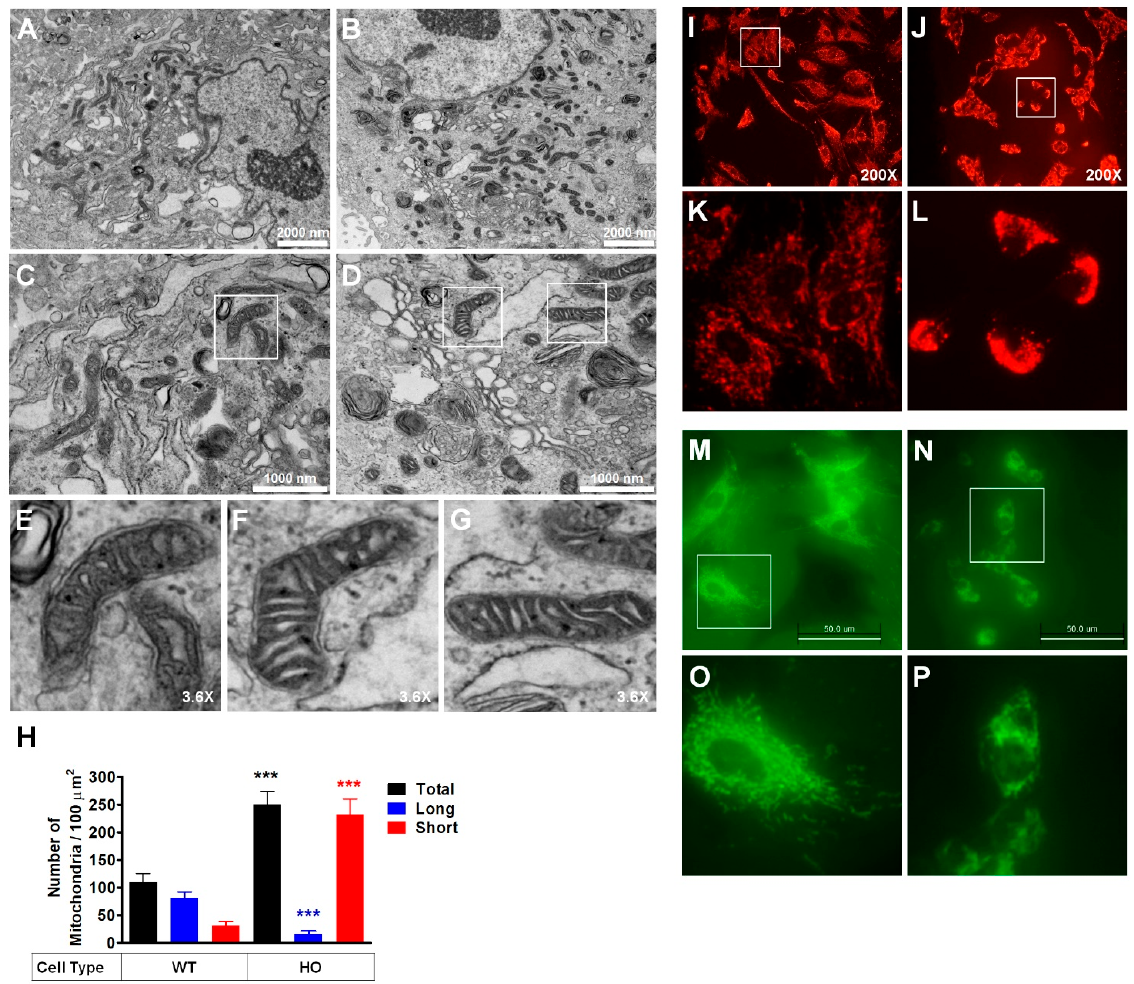
Figure 1. Altered mitochondrial morphology and network. ( A – G ) Representative images showing mitochondrial morphology in WT and GCD2 corneal fibroblasts. EM micrographs of a thin section of corneal fibroblasts show the structure of mitochondria in WT and GCD2 corneal fibroblasts. Many abnormal mitochondria (short or fragmented) were observed in GCD2 cells compared with WT cells. Scale bars are 2000 nm ( A , B ), and 1000 nm ( C , D ). ( H ) Graphs on the right show mitochondrial morphological features. Mitochondrial numbers were measured in 6 WT and 6 GCD2 cells. The ranges of the length parameters of the three shapes of mitochondria were arbitrarily determined as short (<500 nm), long (>500 nm), and total (short + long). The size of mitochondria was measured using Image ( J ) software (version 1.37, Wayne Rasband, NIH ). Results represent the mean ± SD, *** p < 0.001. GCD2 corneal fibroblasts exhibit enhanced mitochondrial fragmentation. ( I – P ) Live imaging of mitotracker ‐ stained mitochondria in WT and GCD2 HO corneal fibroblasts. Representative images of GCD2 corneal fibroblasts and control cells preincubated with MitoTracker Red/Green showing mitochondrial network formation. White boxes in upper panels ( I , J , M , N ) show corneal fibroblasts, which are magnified in lower panels ( K , L , O , P ). Scale bars are 50 μ m ( M , N ). Next, we morphometrically assessed the mitochondrial network by staining live WT and GCD2 corneal fibroblasts with MitoTracker Red FM (Figure 1I–L) and MitoTracker Green FM (Figure 1M,N). In WT cells, mitochondria formed an interconnected network mented, and clustered mitochondria localized in the perinuclear region (Figure 1J,L,N). The GCD2 corneal fibroblasts also showed reduced tubular mitochondrial network compared